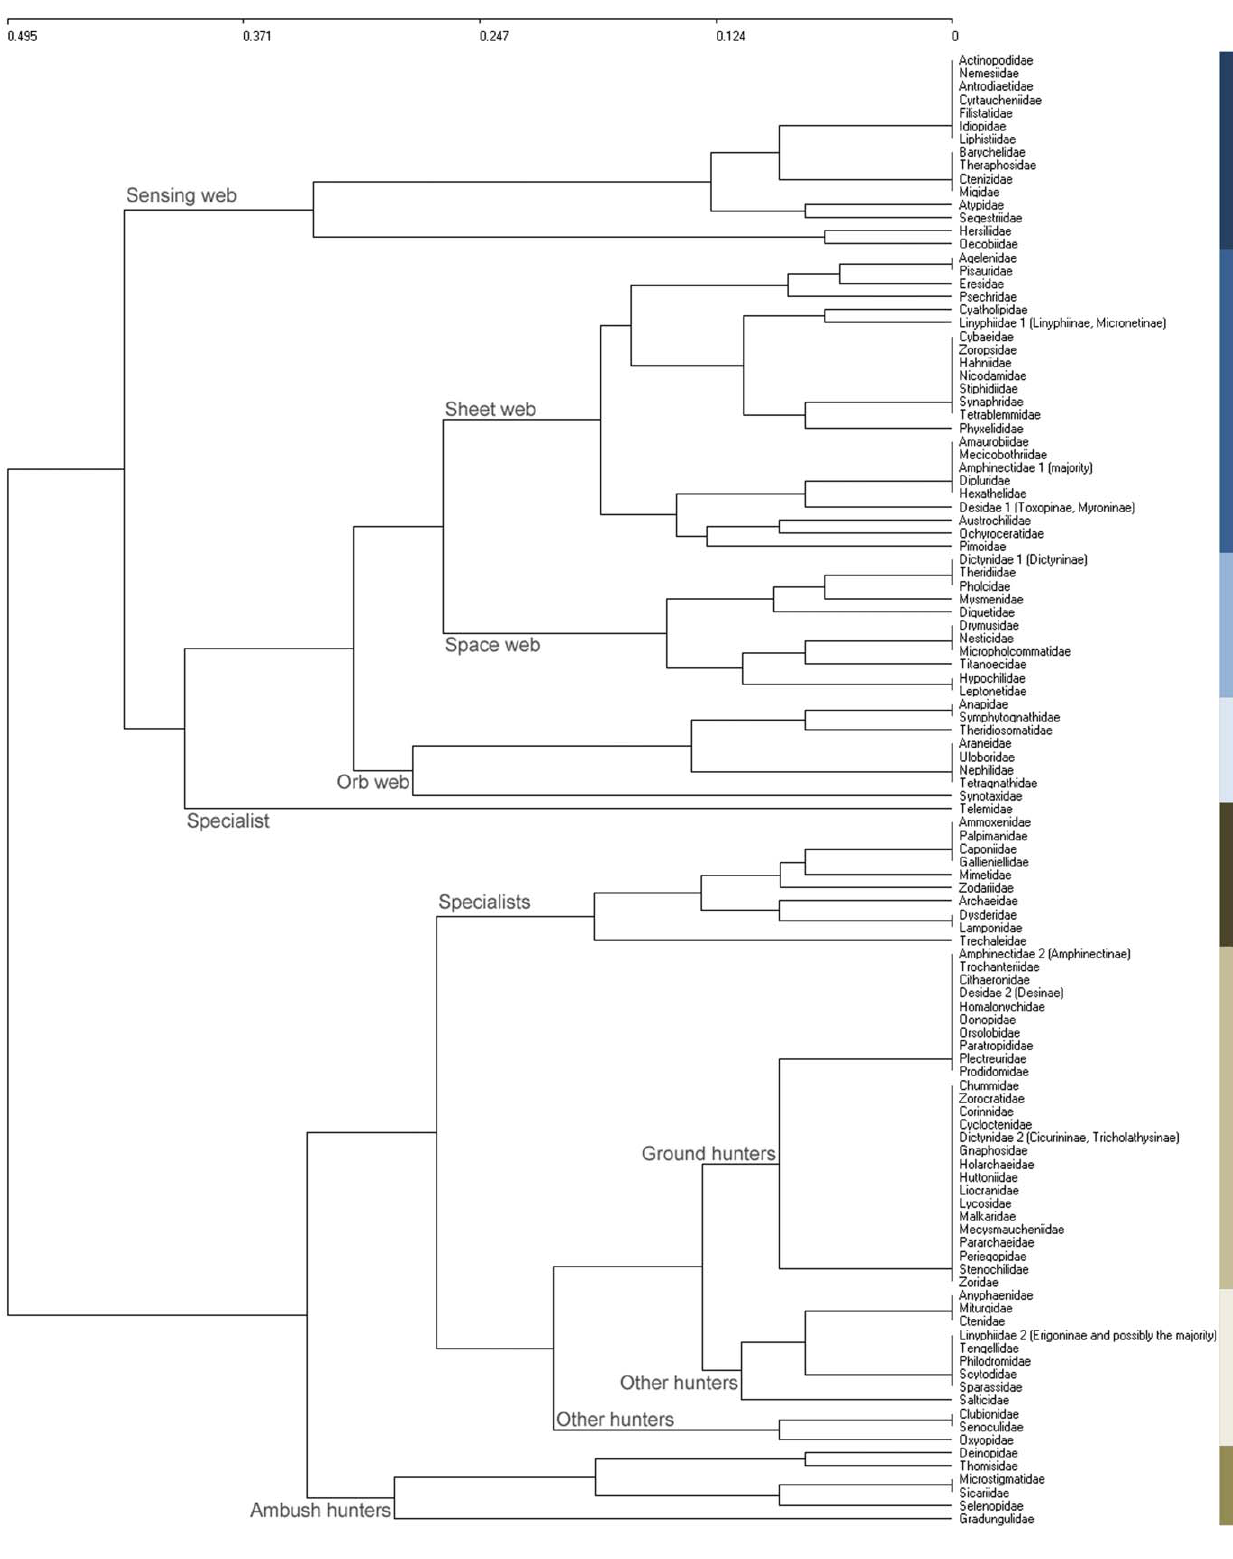
Figure 1. Hierarchical clustering of families. Results for the UPGMA analysis with Sørensen index of dissimilarity applied to the ecological characteristics of spider families. Names of eight distinguished guilds are shown.